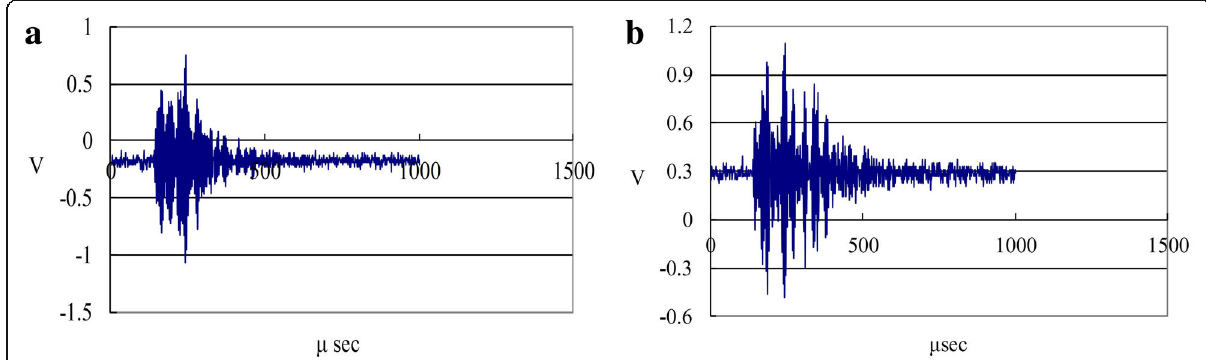
Fig. 9 Waveform data of concrete phantom; a waveform data of phantom A, b waveform data of phantom B